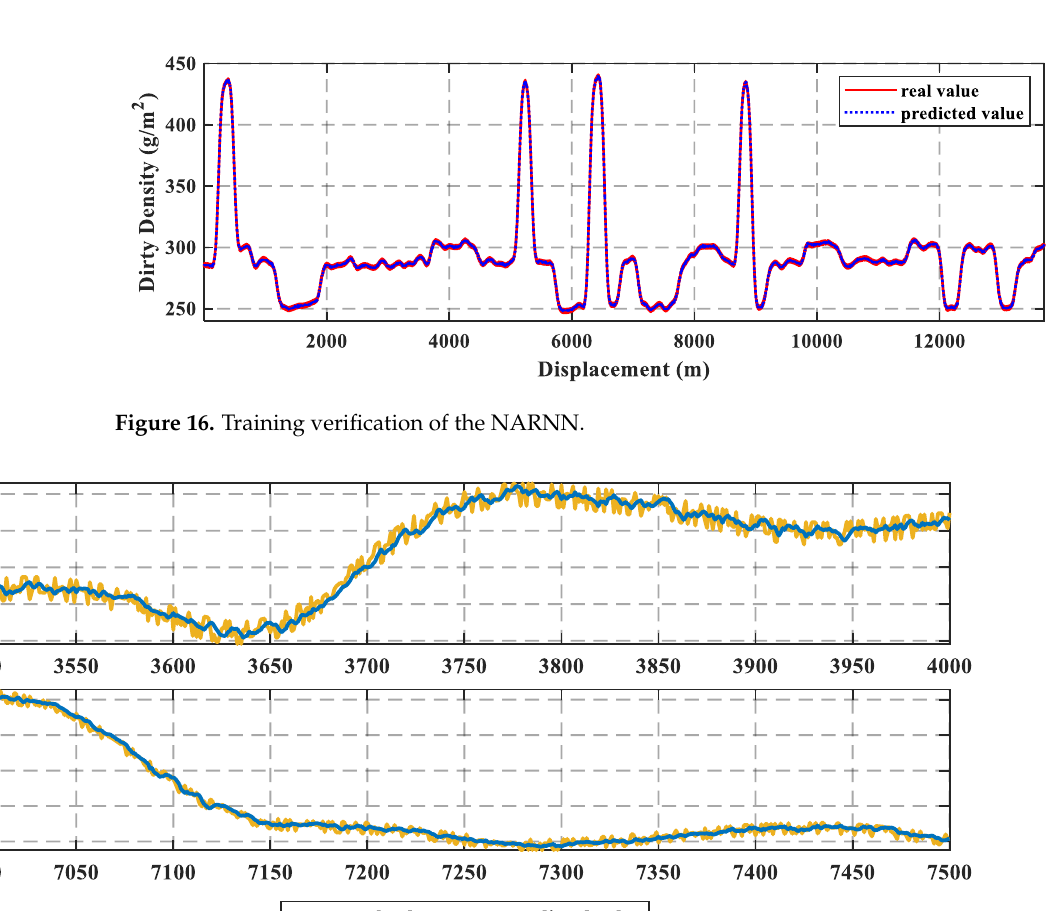
Figure 17. Details of training performance of the NARNN.